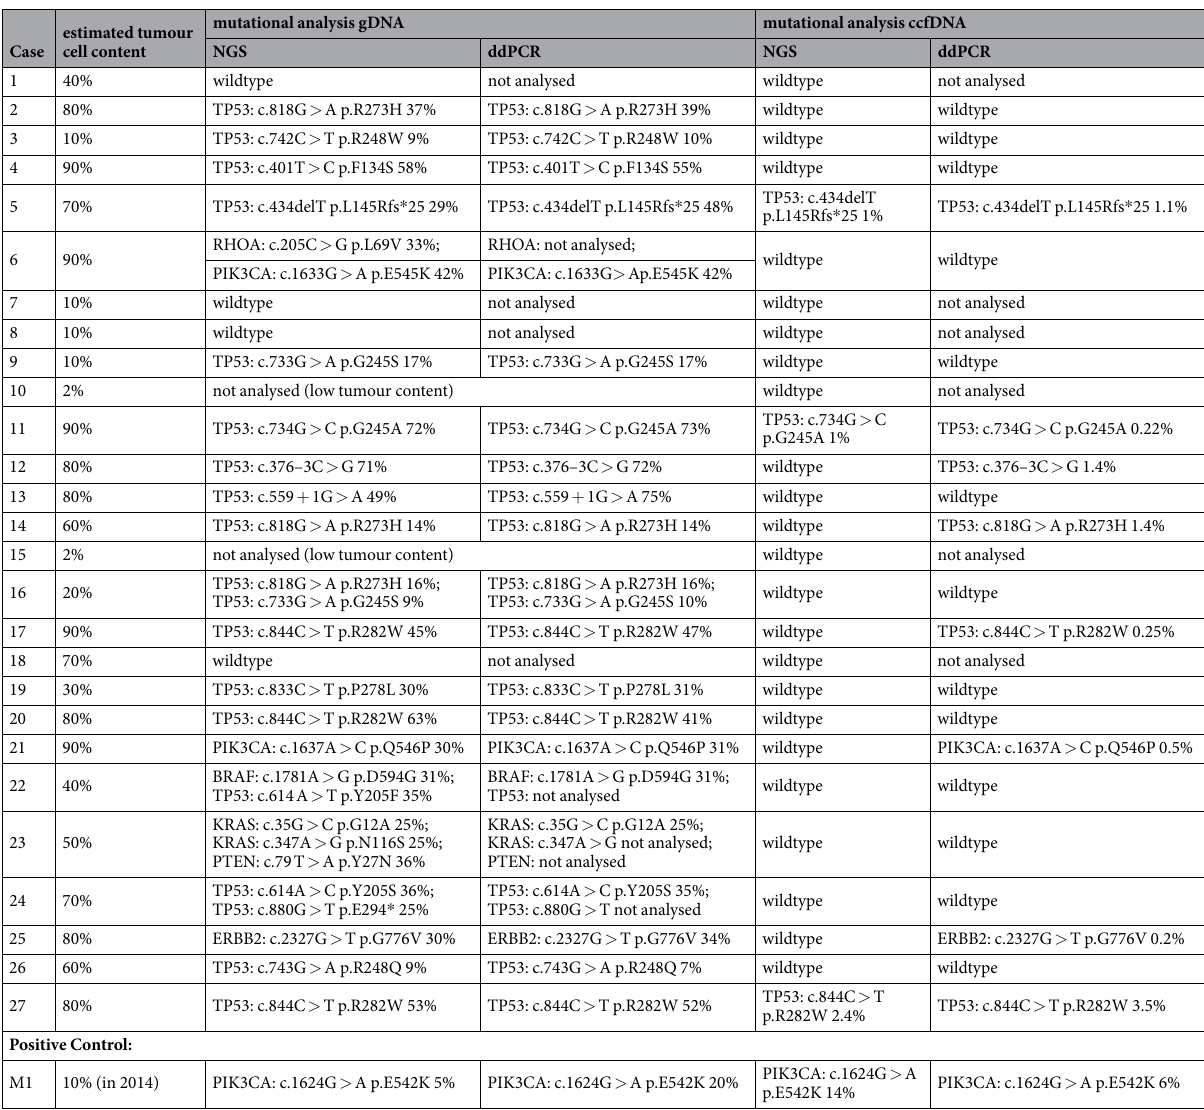
Table 2. Detectable somatic mutations in circulating cell-free DNA (ccfDNA) from blood plasma compared to genomic DNA (gDNA) derived from the surgical tumour specimens utilising next-generation sequencing